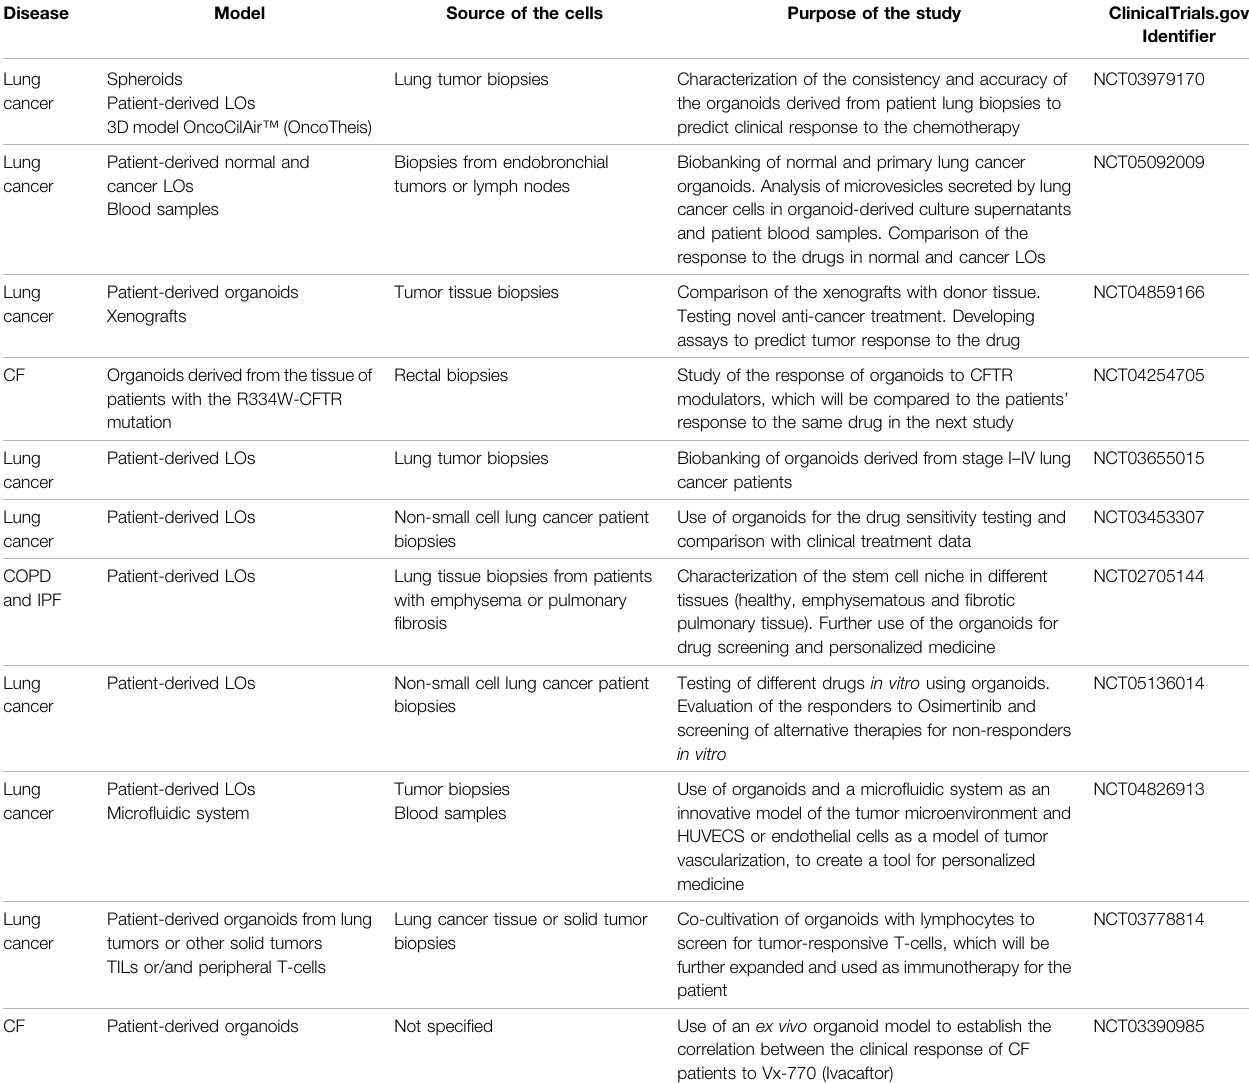
TABLE 2 | Clinical trials in lung organoids: List of the clinical trials using 3D LOs as in vitro models.